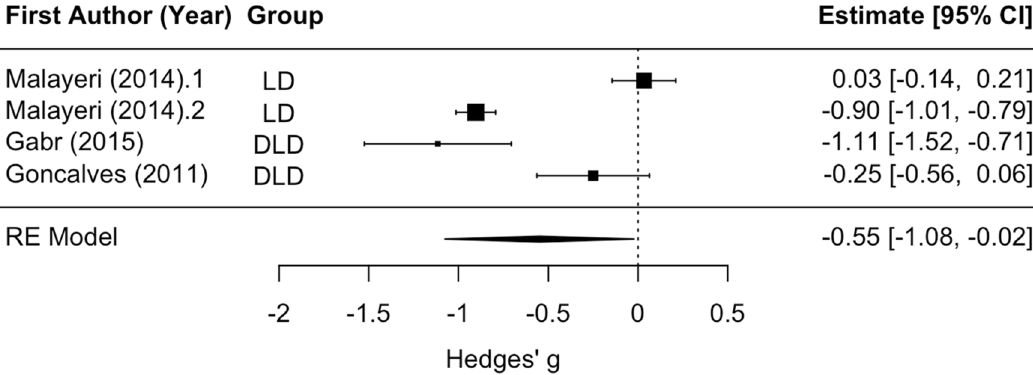
Figure 7. Wave A/Vn Amplitude forest plot. Negative values of Hedges’ g indicate lower amplitude in the disorder group relative to the control group. Although subgroup and analyses of stimulus type were not possible due to the limited number of effect sizes in this analysis, the two statistically significant effects were from articles with two different stimulus types (Malayeri (2014).2 – speech, Gabr (2005) – clicks), so differences between papers were not likely due a difference between speech and non-speech stimuli. Rows with decimal points after the article year indicate multiple analyses from the same paper, and correspond to the row order of the analysis in the systematic review table in Supplement D.